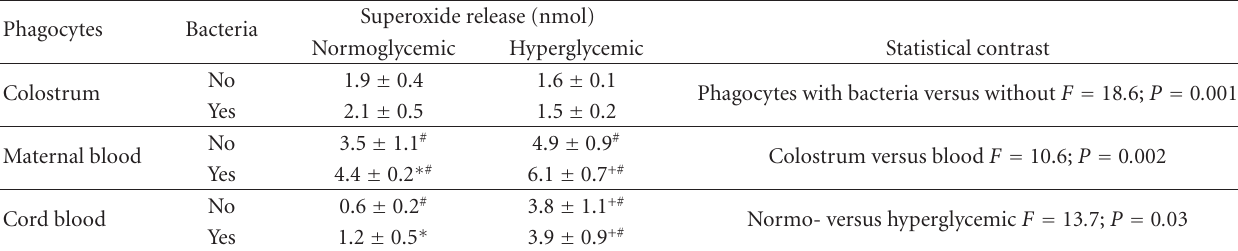
Table 3: Superoxide release by colostrum and blood mononuclear phagocytes (mean ± SD, N = 10 in each treatment). Phagocytes